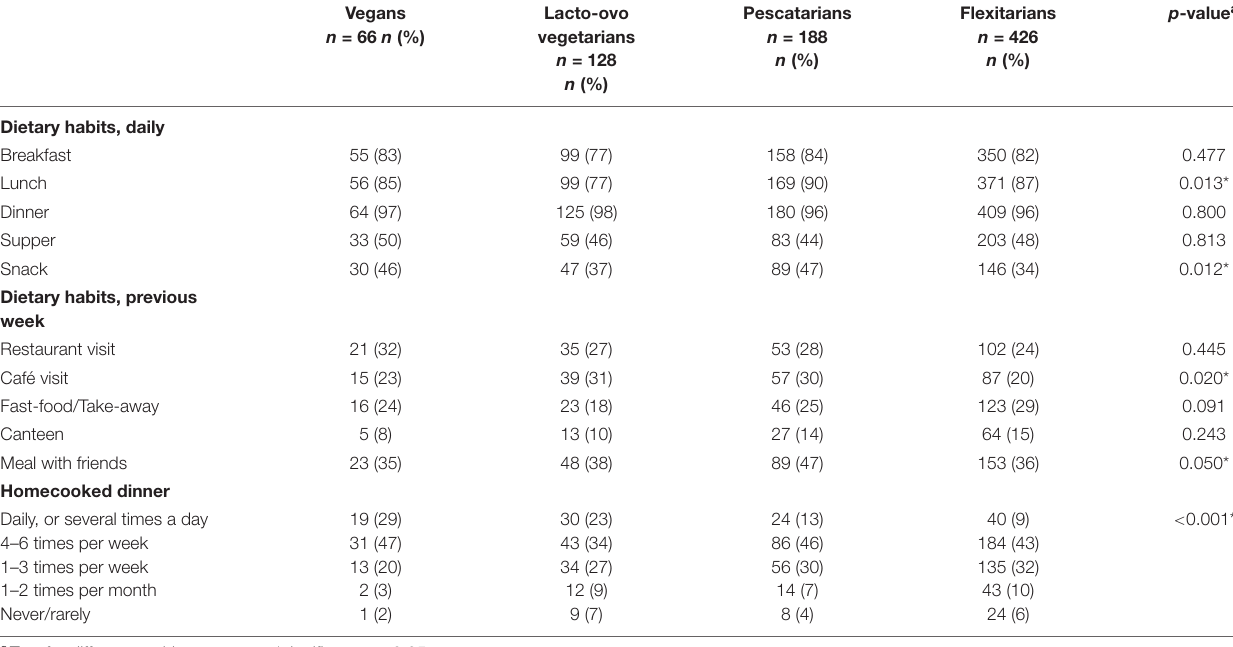
TABLE 2 | Dietary habits and meal frequency of adult vegans, vegetarians, pescatarians, and flexitarians in Norway ( n = 808).